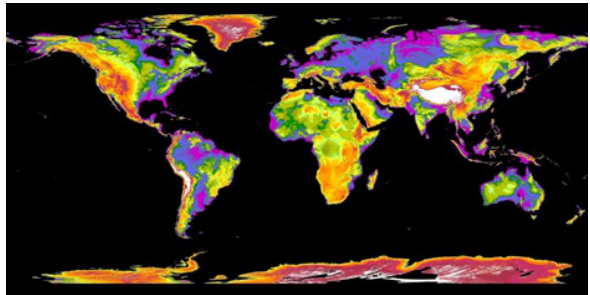
Figure 3 . Colorized global mosaic of GDEM V3. White and red are highest elevations, black is ocean at 0 m elevation.